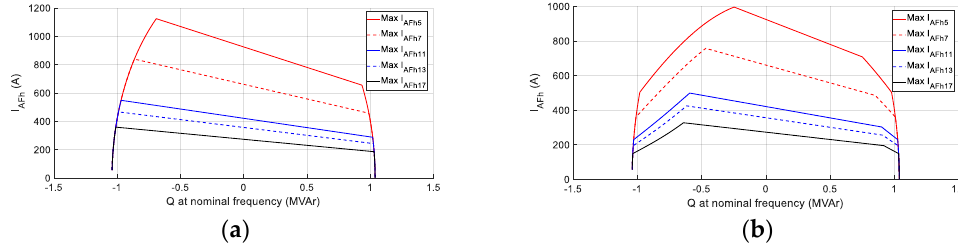
Figure 11. Maximum current at nominal voltage for different harmonics and injected reactive power: ( a ) considering a correctly sized transformer and ( b ) considering a transformer designed with K < 2.